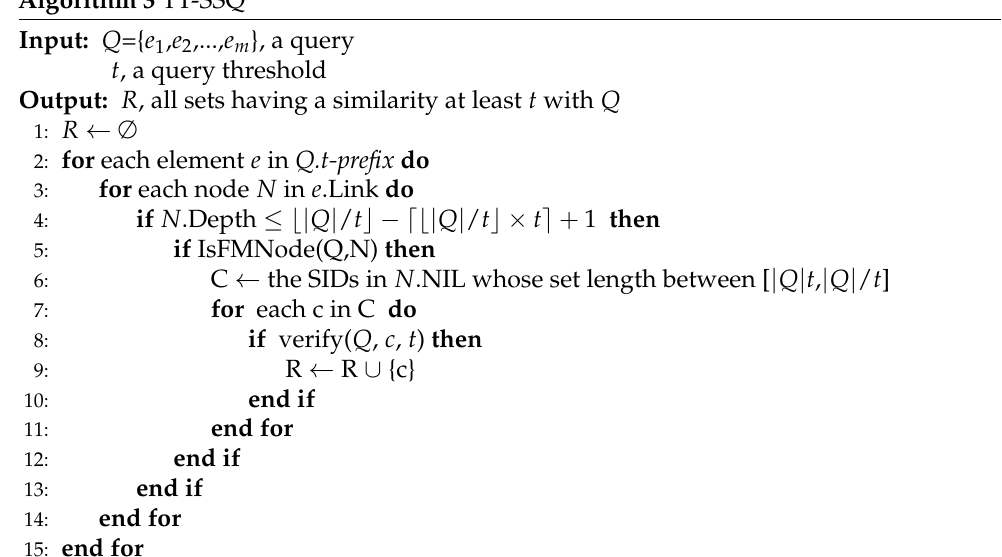
Algorithm 3 TT-SSQ